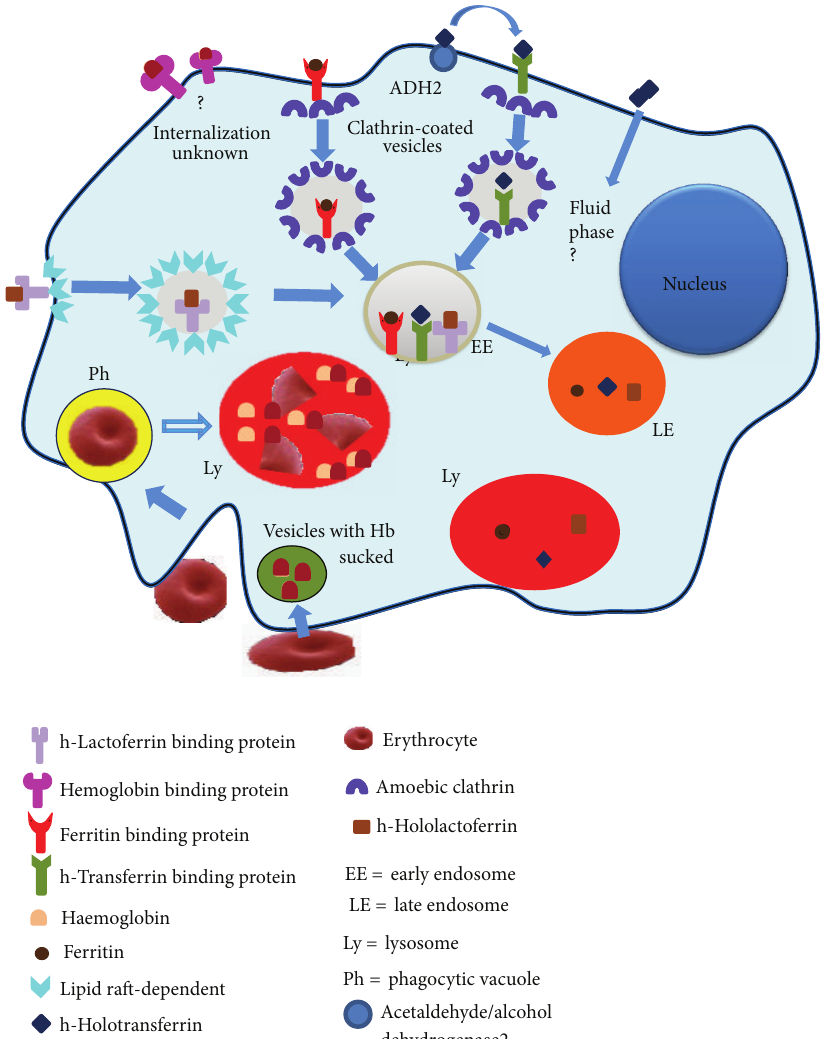
Figure 7: Host proteins containing iron are internalized and degraded by amoebic proteases for use as iron sources for growth.